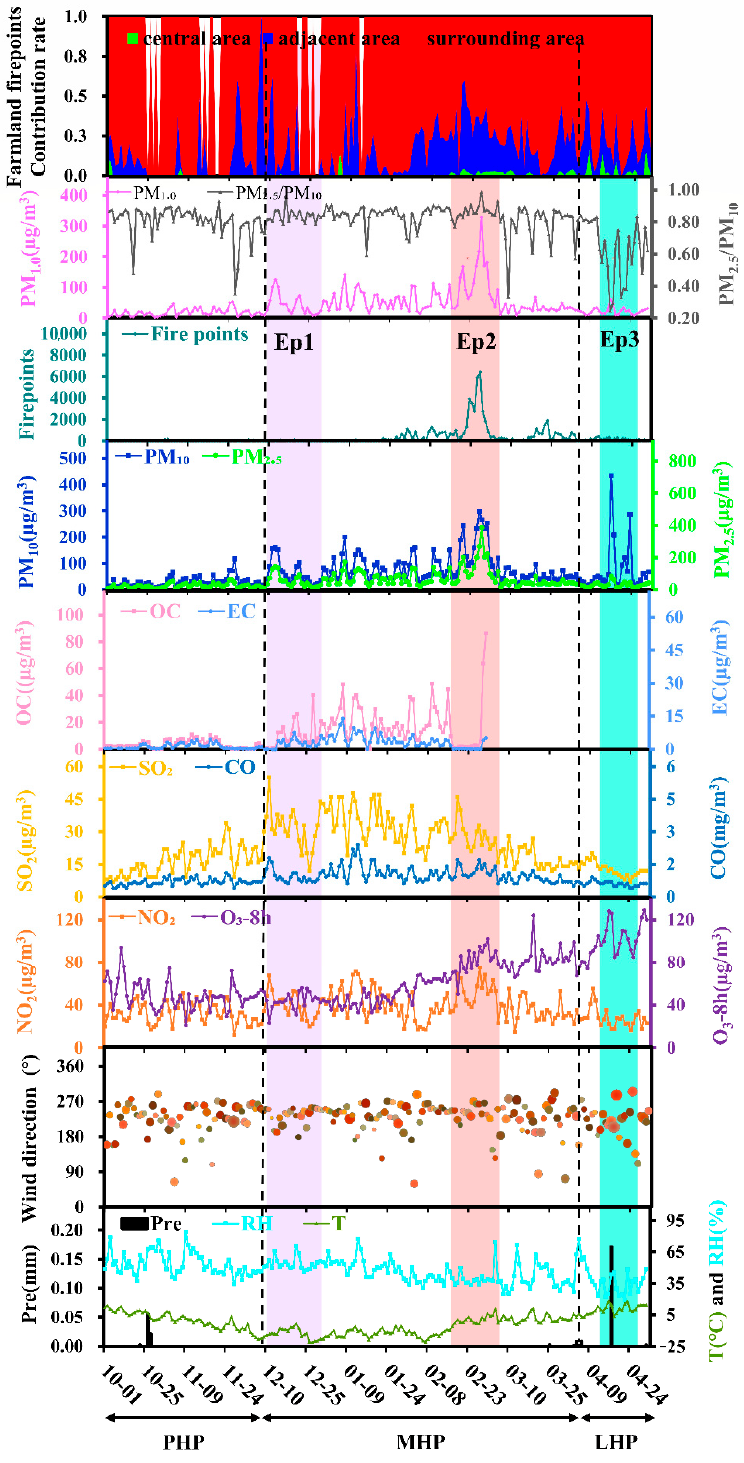
Figure 2. Temporal variation of farmland fire points, PM 1.0 concentration and ratios of PM 1.0 and PM 2.5 , PM 2.5 and PM 10 , SO 2 and CO, NO 2 and O 3 -8 h concentration; and wind direction (WD) and wind speed (WS), temperature (T), relative humidity (RH), and precipitation (Pre) from 1 October 2018 to 30 April 2019. Three periods (PHP, MHP and LHP) were divided by the black dotted line and three haze events (Ep1, Ep2 and Ep3) were marked with purple, red, and green, respectively.